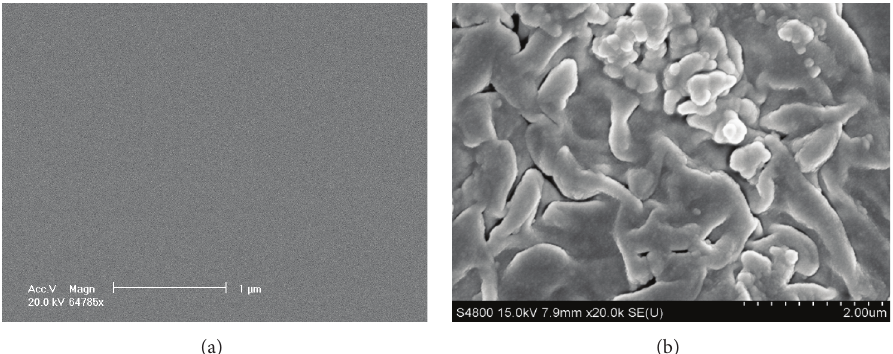
Figure 2: (a) GCE scanning electron microscopy. (b) PLH/GCE scanning electron